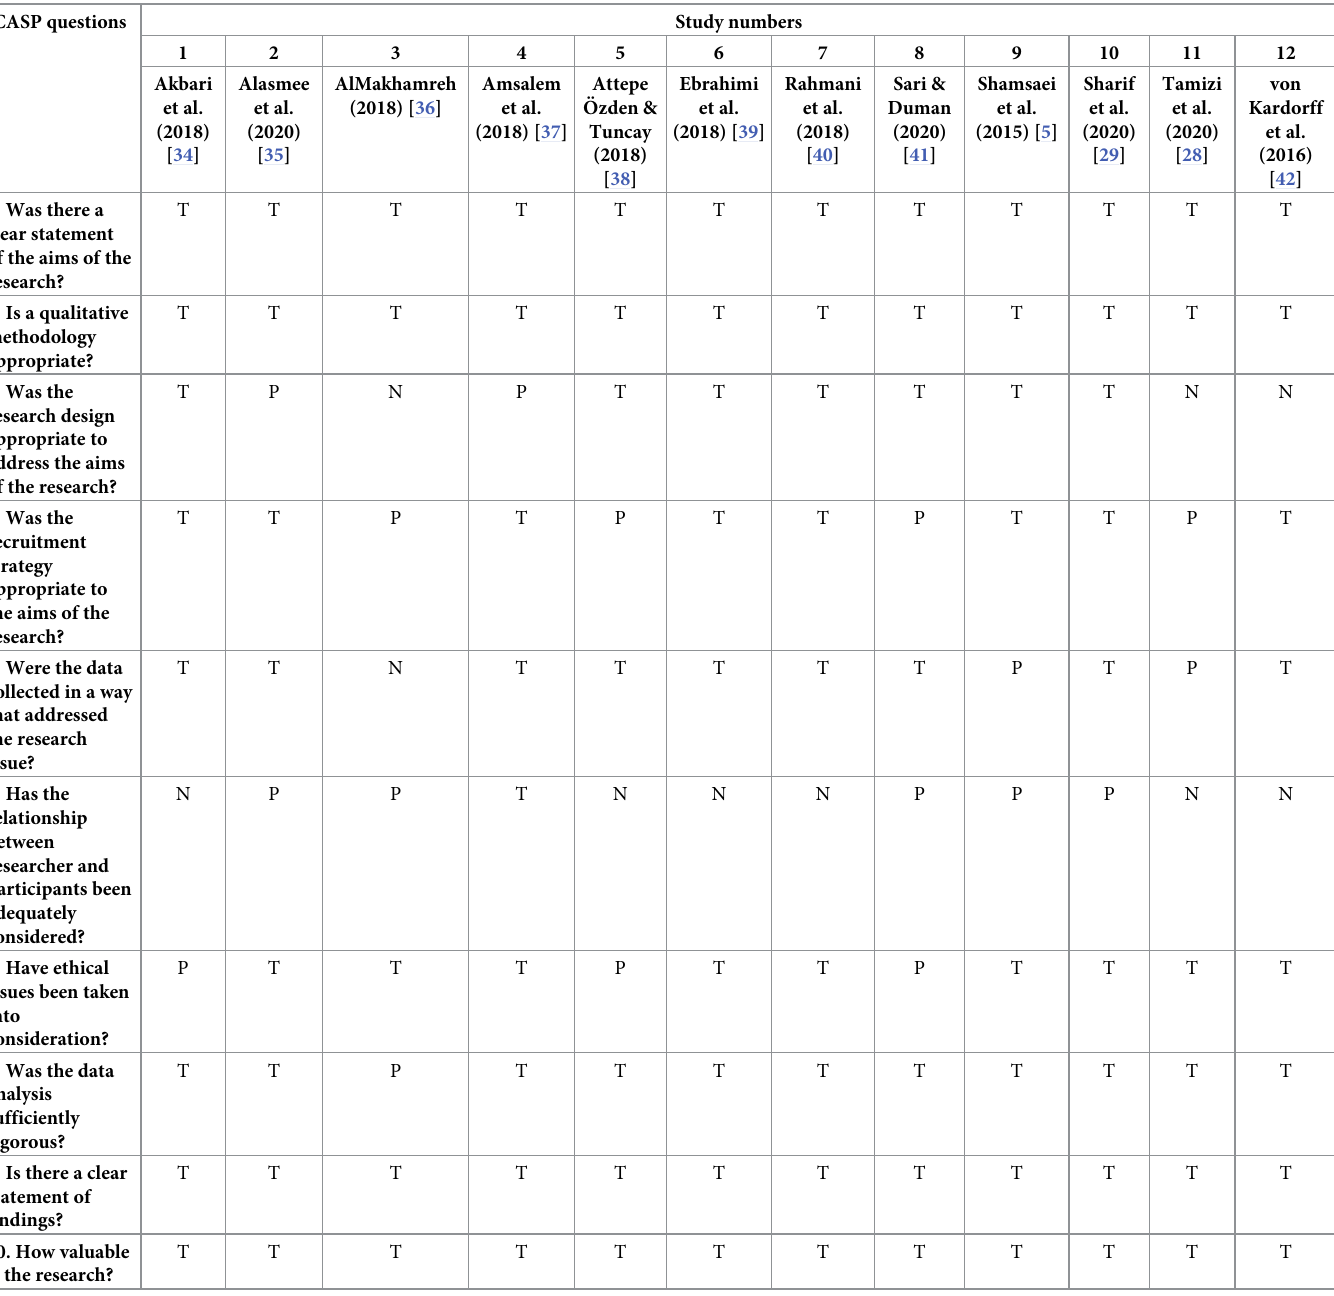
Table 2. Full CASP assessment on twelve